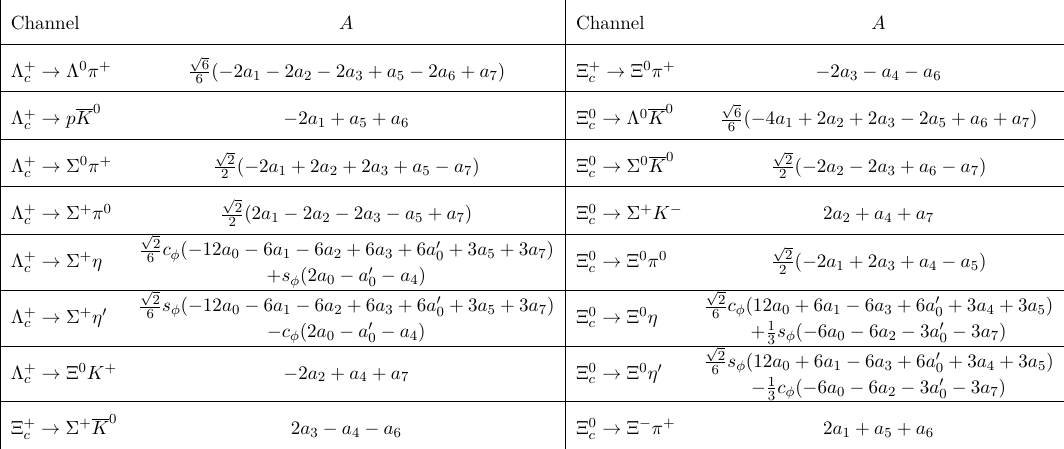
Table 1 . The S-wave amplitudes for Cabibbo-favored decays of B c → B n M in terms of coefficients of irreducible representation amplitudes (IRA). The P -wave amplitudes can be obtained by replacing a i by b i accordingly.